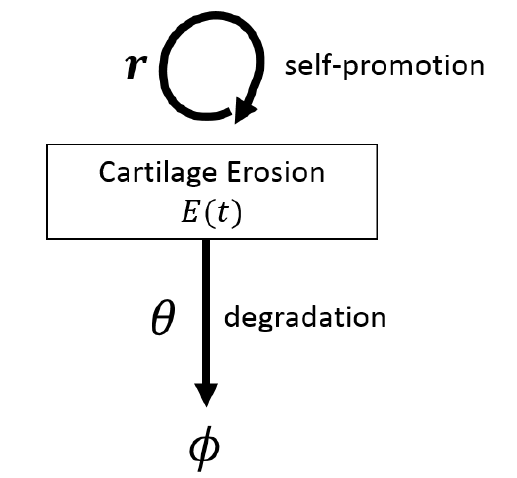
Figure 2. Schematic description of the logistic growth/decay for cartilage erosion introduced in [46]. The model considers only one variable, the cartilage erosion over time t , which is denoted by E ( t ) in Equation (1). Here φ represents cartilage removed from the